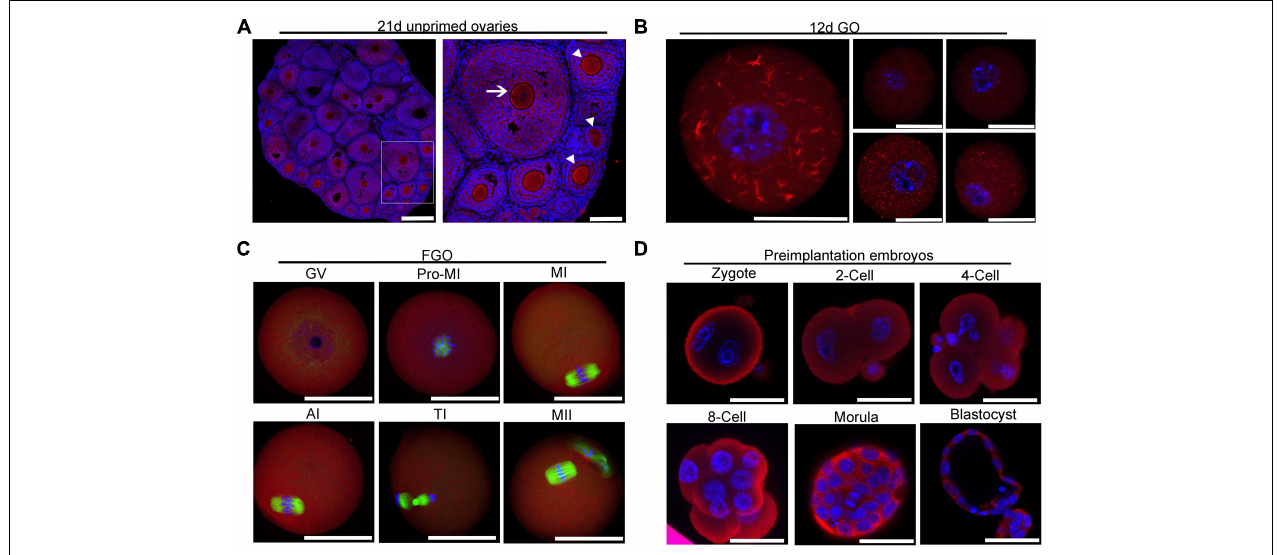
FIGURE 2 | Localization of IMPDH2 in the ovary, oocytes and preimplantation embryos. (A) IF staining of IMPDH2 protein in the ovary isolated from 21 day-old female mice that were not primed with eCG. The arrow indicates the oocyte within a small antral follicle, arrowheads point to oocyte in early stage growing follicles. In this and the following all figures, IMPDH2 is stained in red, DNA is counterstained in blue. Scale bars, except those in B that represent 20 µ m, are 50 µ m. (B–D) Whole mount IF staining of IMPDH2 in the growing oocytes isolated from the ovaries of 12 d-old female mice (B) ; fully grown oocytes (FGO) at different maturation (GV, Pro-MI, MI, AI, TI, and MII) stages (C) ; and preimplantation embryos at different developmental (PN, 2-Cell, 4-Cell, 8-Cell, Morula, and Blastocyst) stages (D) . In (C) , α -tubulin is stained in